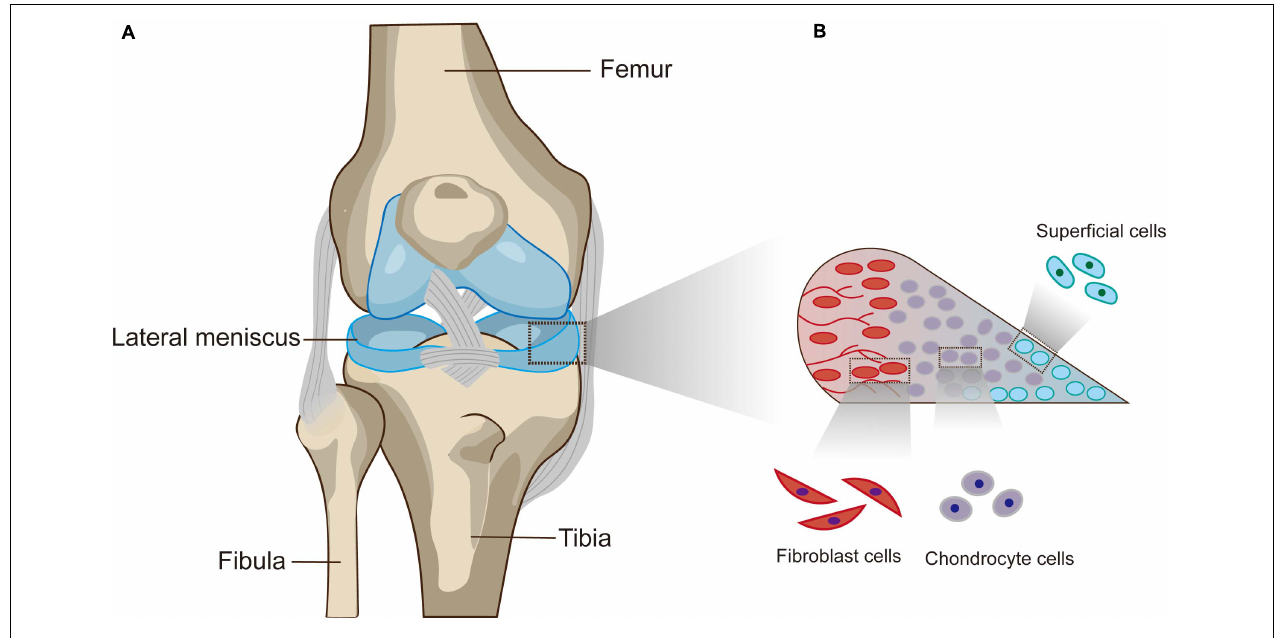
FIGURE 1 | (A) Basic anatomy of the knee. (B) Cross-sectional diagram of the